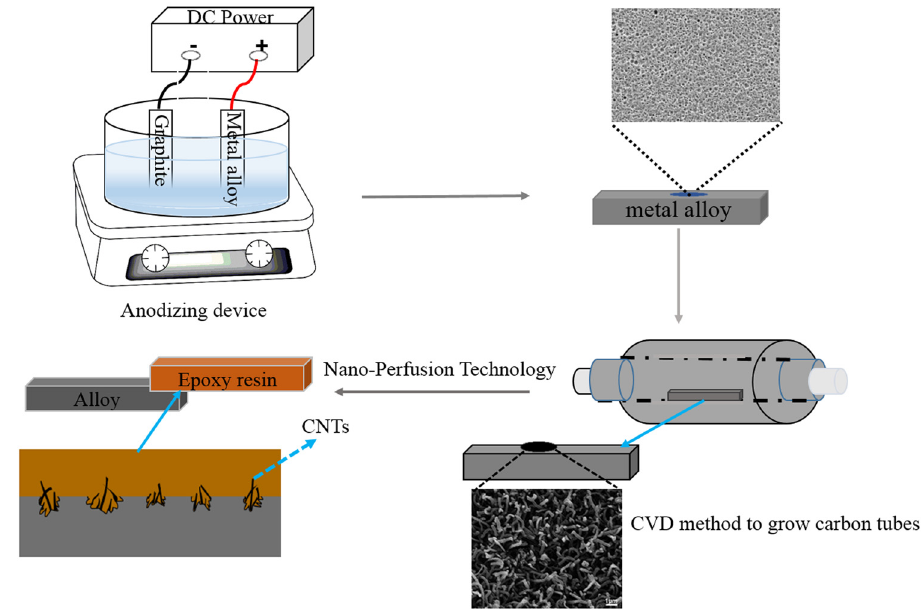
Figure 1: Schematic diagram of metal - resin composite preparation